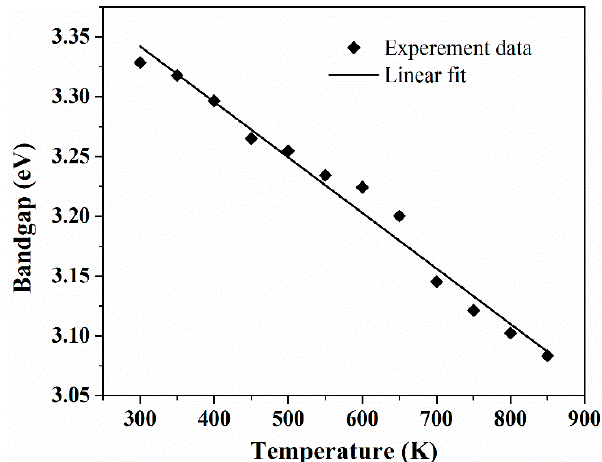
Figure 10. The bandgap values vs. temperature of sample S 0 at 300 K–850 K.